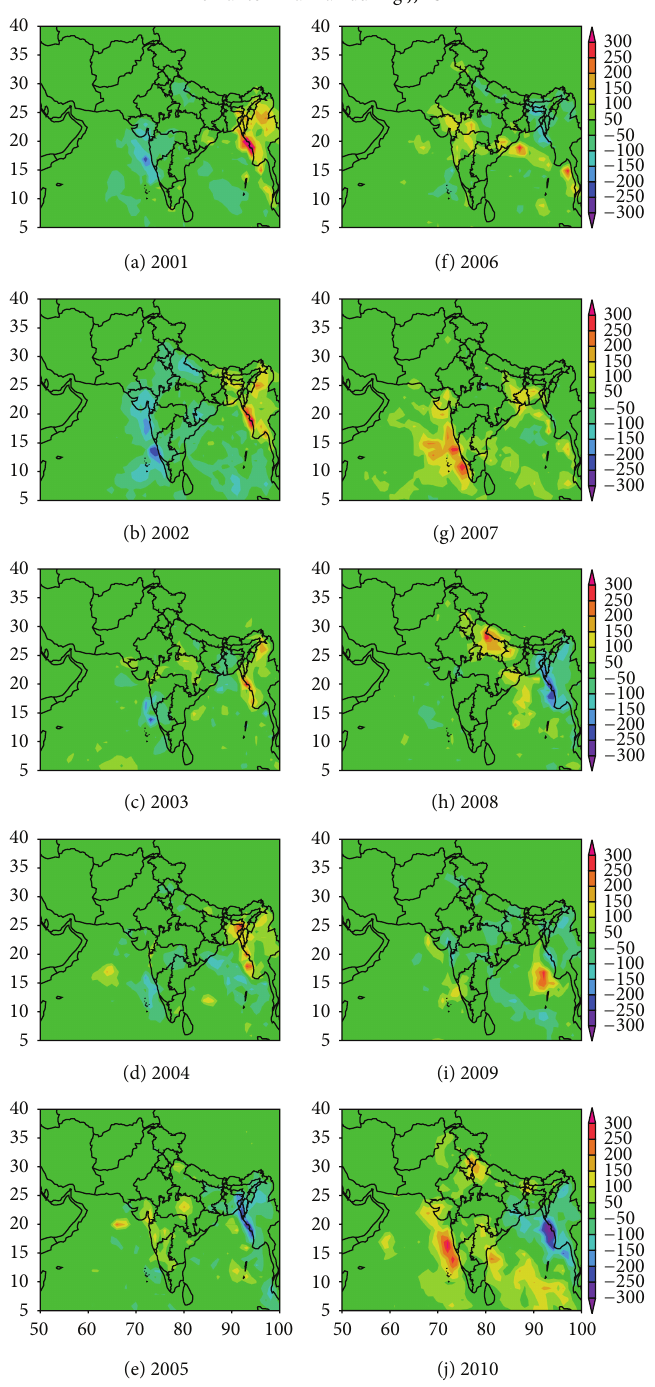
Figure 10: Anomalies in rainfall (mm) during the southwest monsoon season (JJAS) in (a) 2001, (b) 2002, (c) 2003, (d) 2004, (e) 2005, (f) 2006, (g) 2007, (h) 2008, (i) 2009, and (j) 2010 over the Arabian Sea, India, and the Bay of Bengal.